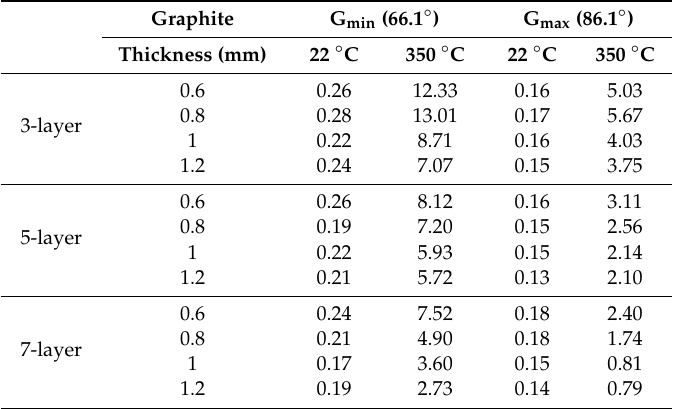
Table 6. Maximum contact stresses of